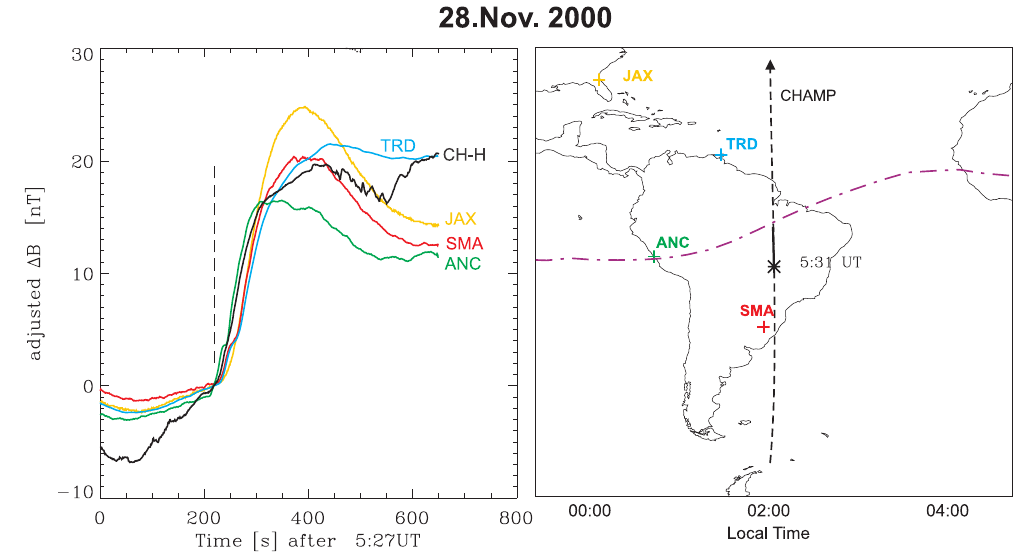
Fig. 3. Same as Fig. 2, but for the SC event on 2 November 2000, when CHAMP flew over South America. increase gets larger towards higher magnetic latitudes. The curve of the CHAMP H component lies between the CAN ( − 43 ◦ ) recordings and the measurements at the lower lati- tude stations. When CHAMP passes the latitude of CAN the two signal curves are crossing. This indicates that the mag- netic deflection caused by an SC continues to rise towards higher latitudes. Current systems responsible for that are dis- cussed in Sect.